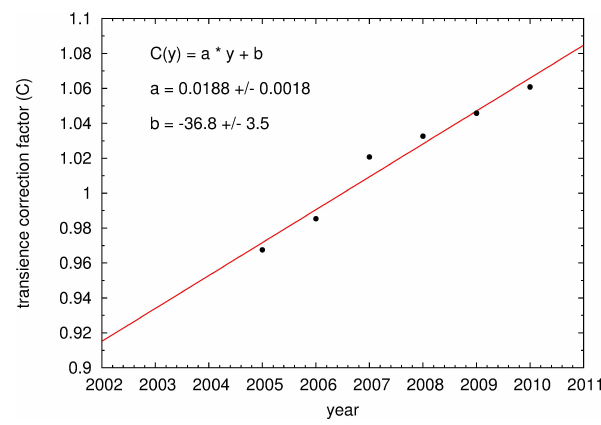
Figure 2. Combined transience correction factors C = C 2 /C 1 for CFC-12 vs. CFC-11, which we calculated from data of Brown et al. (2013). The red line shows a linear fit to the data; see plot labels for fit parameters and statistical